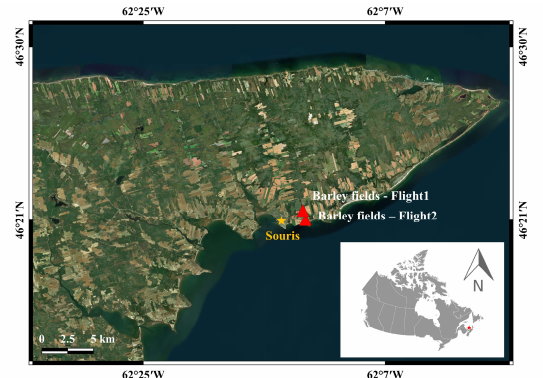
Figure 1. Location of the study sites in Prince Edward Island. ESRI Satellite (ArcGIS/World